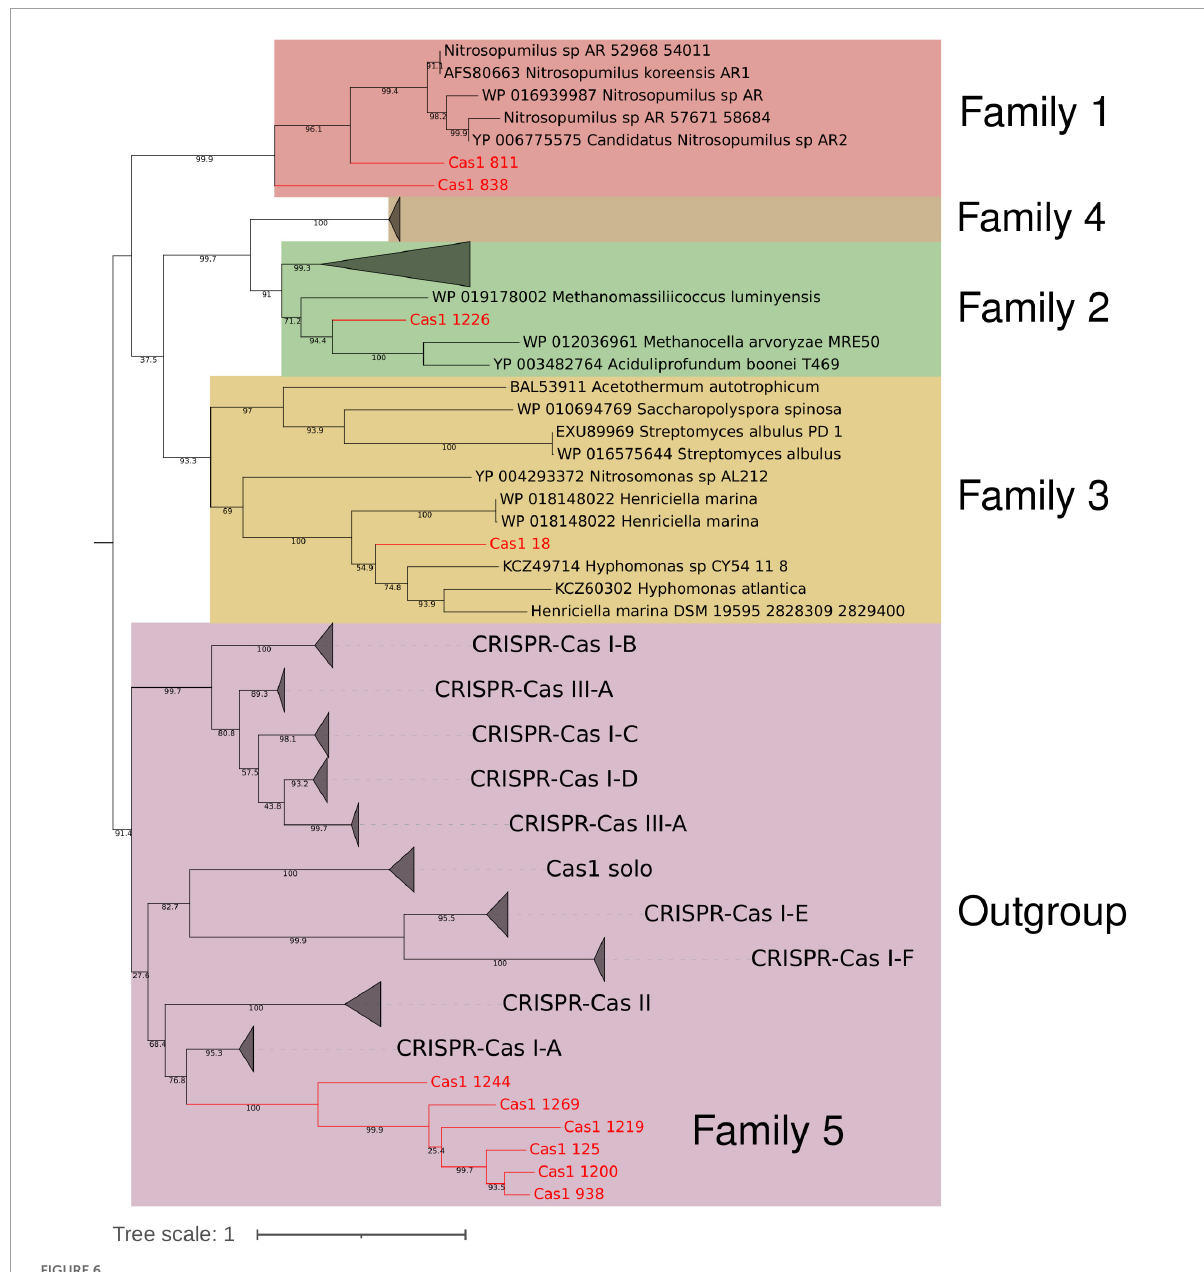
FIGURE6 Reconstructed maximum likelihood phylogenetic tree of Krupovic et al. (2014, 2016). Ten hot spring casposases (colored red and with ID indicated in Supplementary Table 3 ) were analyzed along with 110 reference casposases. Clades are colored according to the described casposase family (1–4) or outgroup, except family 5, which is indicated inside the outgroup in red, close to Cas1 of subtype I-A CRISPR-Cas system. Bootstrap values are indicated in branches as a